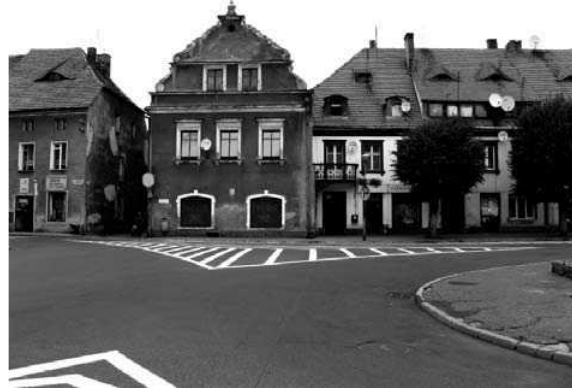
Fig. 5. Market square of Cieszków town (actually a village), surrounded by lime